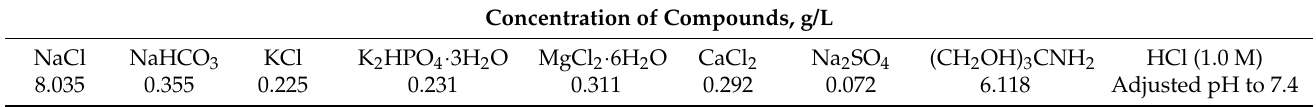
Table 3. Composition of the simulated body fluid (SBF)